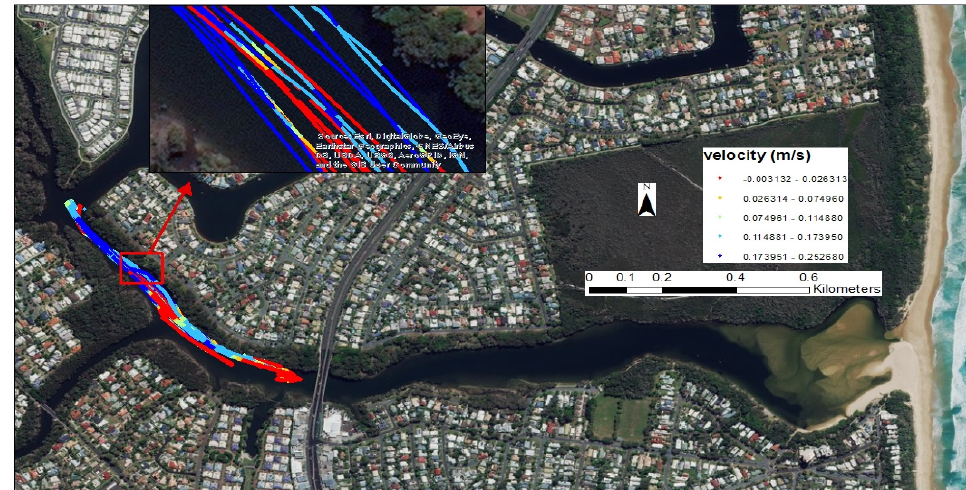
Figure 10. Trajectories from 13:30 to 16:00 on 28 April 2015 with an open entrance and flood condition. Source: ArcGIS software by Esri.